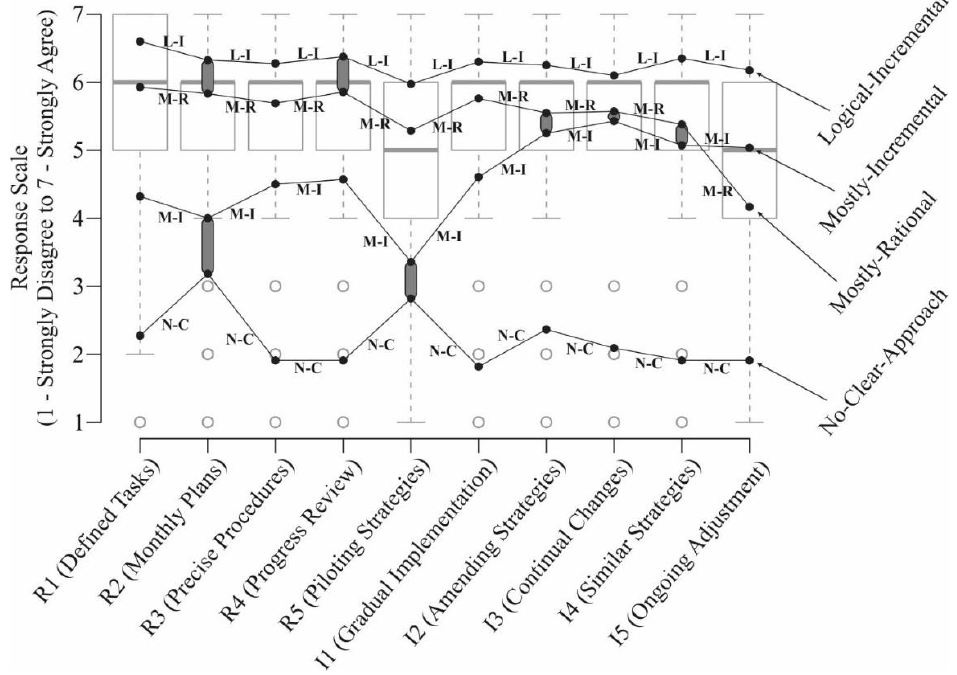
Figure 1. Constituent means for strategy implementation clusters.